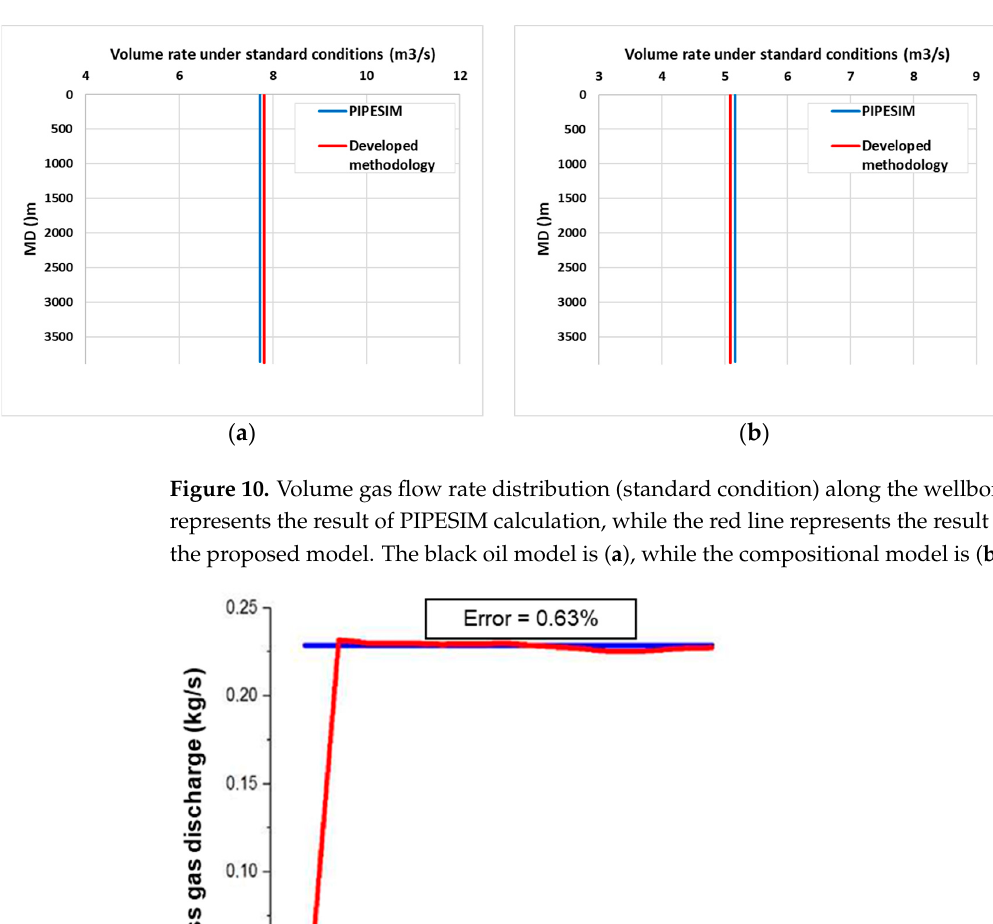
Figure 9. Mass gas flow rate distribution along the wellbore. The blue line represents the result of PIPESIM calculation, while the red line represents the result of calculation of the proposed model. The black oil model is ( a ), while the compositional model is ( b ).